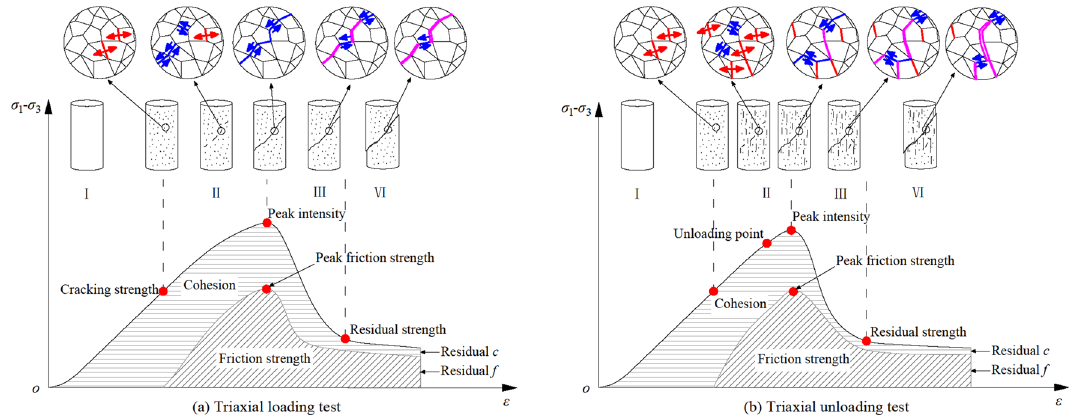
Figure 8. Schematic diagram of rock failure process under different stress